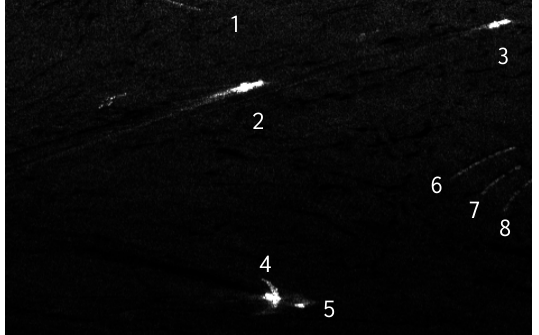
Figure 11. The span image of AIRSAR on 4th